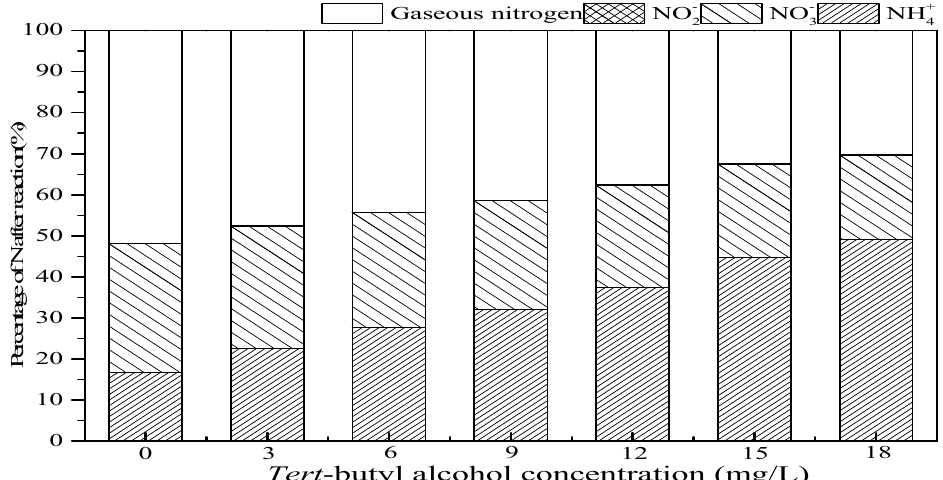
Figure 9. Effect of tert -butanol on ammonia conversion in SrO-Al 2 O 3 / US / O 3 system. Reaction conditions: initial NH 4 + concentration 50 mg / L, initial pH 9.5, ozone flow 0.8 g / h, catalytic dosage 2.0 g / L, temperature 25 ◦ C, reaction time 60 min, ultrasonic frequency 25 kHz, ultrasonic power 270 W, duty cycle 1:3.